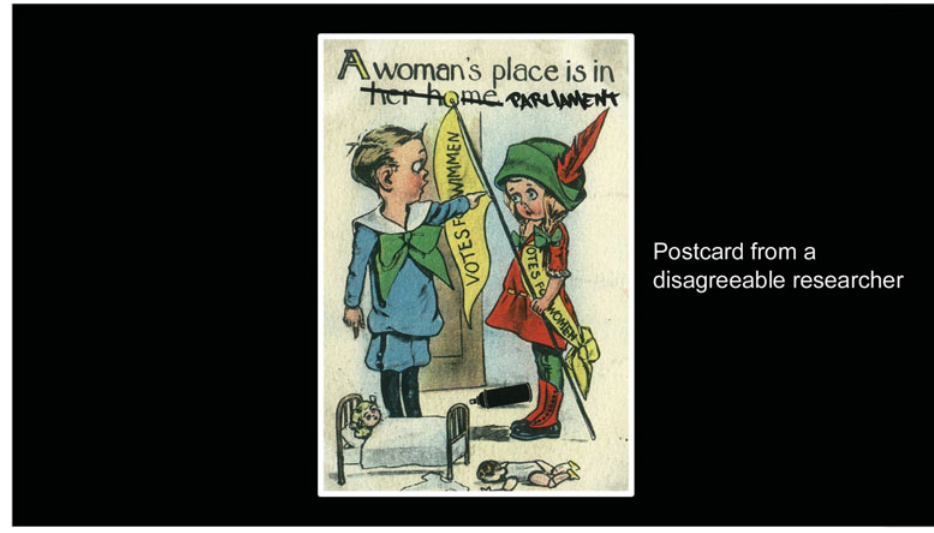
(Colour online) Postcard, written and authorised by Tony Krone, Canberra. Original image used with kind permission from: Palczewski, Catherine H.